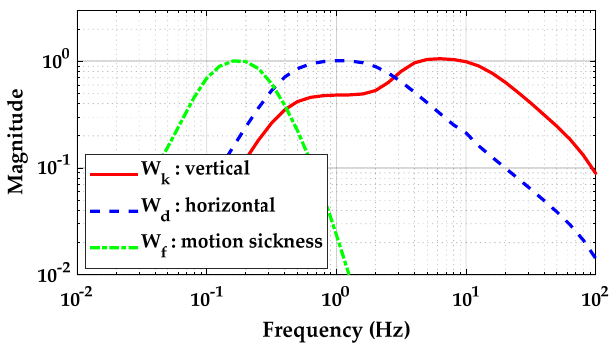
Figure 1. Frequency weightings specified in ISO 2631-1 standard [2].